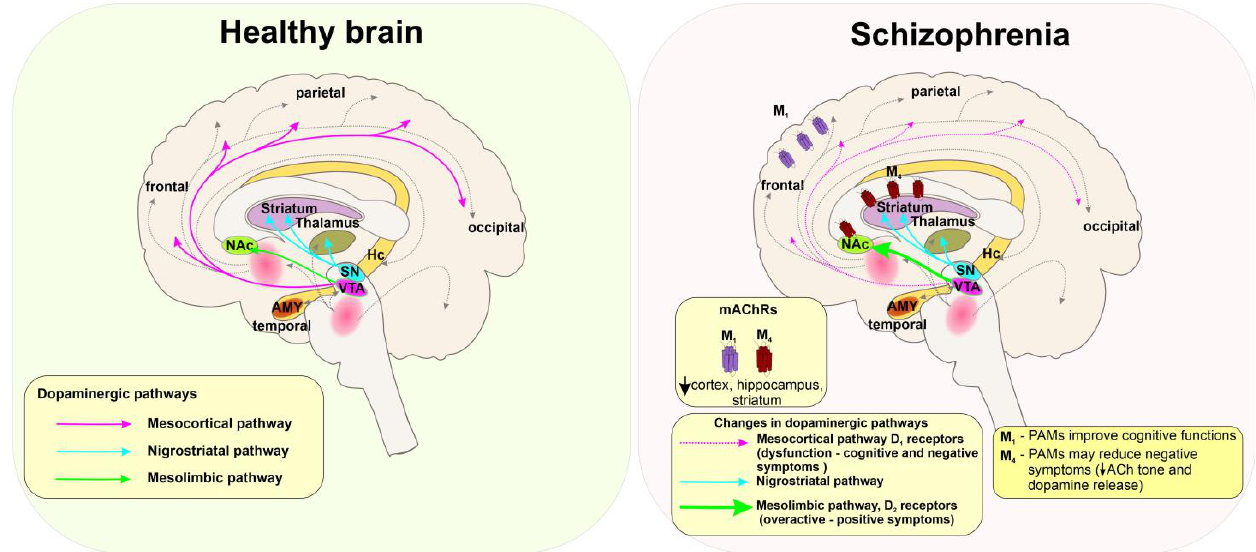
Figure 3. Changes in the human brain associated with schizophrenia. Left : In the healthy brain dopaminergic pathways arising from the ventral tegmental area (VTA) project into the neocortex (mesocortical pathway, pink), and to the nucleus accumbens (NAc) (mesolimbic pathway, green), while substantia nigra (SN) projects into the striatum and thalamus (nigrostriatal pathway, cyan). The distribution of dopaminergic projections greatly overlaps with cholinergic pathways (grey dashed lines). Right: In schizophrenia, dysfunction of the mesocortical pathway and decreased D 1 receptors activation (dashed pink lines) are associated with negative symptoms. Overactive mesolimbic pathways (thick green lines) and increased activity of D 2 receptors are related to positive symptoms of schizophrenia. Selective modulation of the central M 1 and M 4 receptors may represent the possible treatment of both negative and positive symptoms of the disease according to [144].